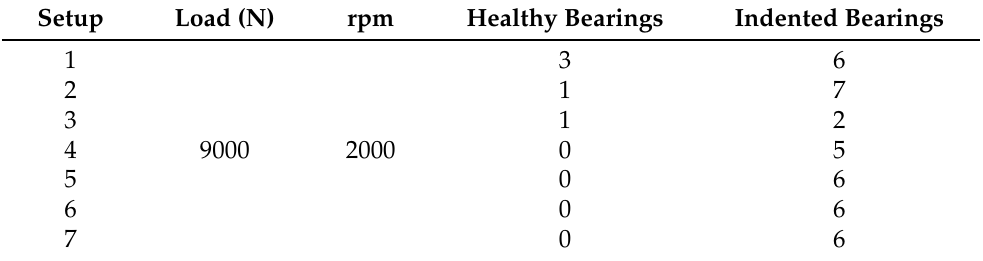
Table 2. Smart Maintenance Living Lab dataset.